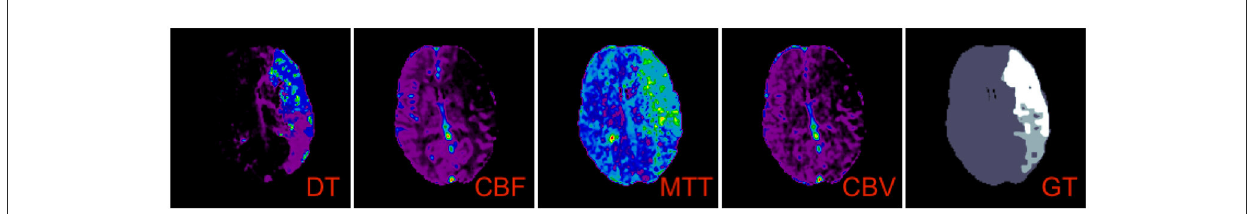
FIGURE1 Feature maps and lesion map corresponding to the M1 test image. A single axial slice is shown with corresponding perfusion data for delay time (DT), cerebral blood flow (CBF), mean transit time (MTT) and cerebral blood volume (CBV). The corresponding class labels which make up the lesion map, used as ground truth (GT) in the algorithm, is shown on the far right.